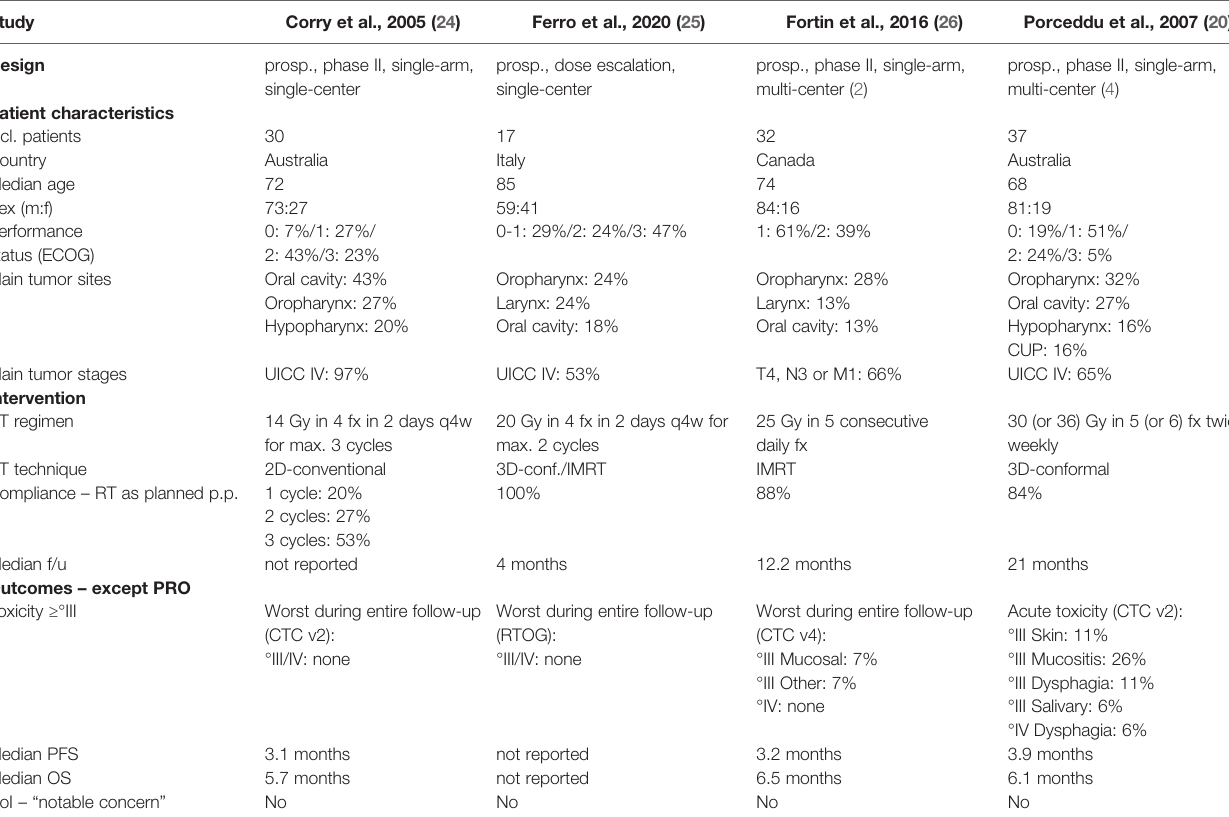
TABLE 2 | Characteristics of eligible